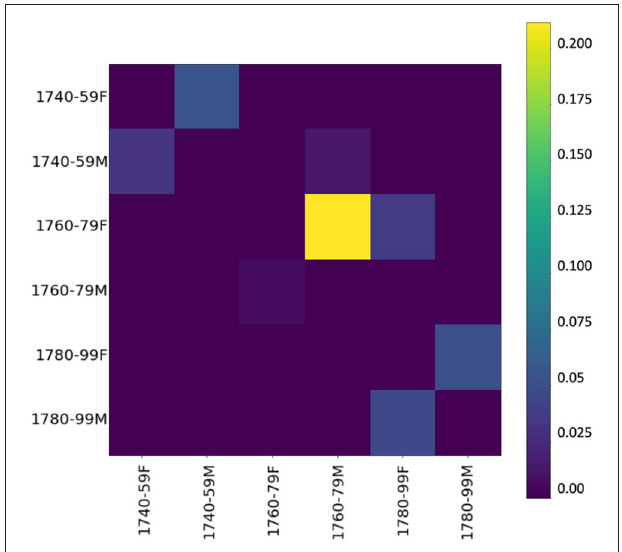
FIGURE 12 | Influencer heatmap of event cascades over time at the morphological level